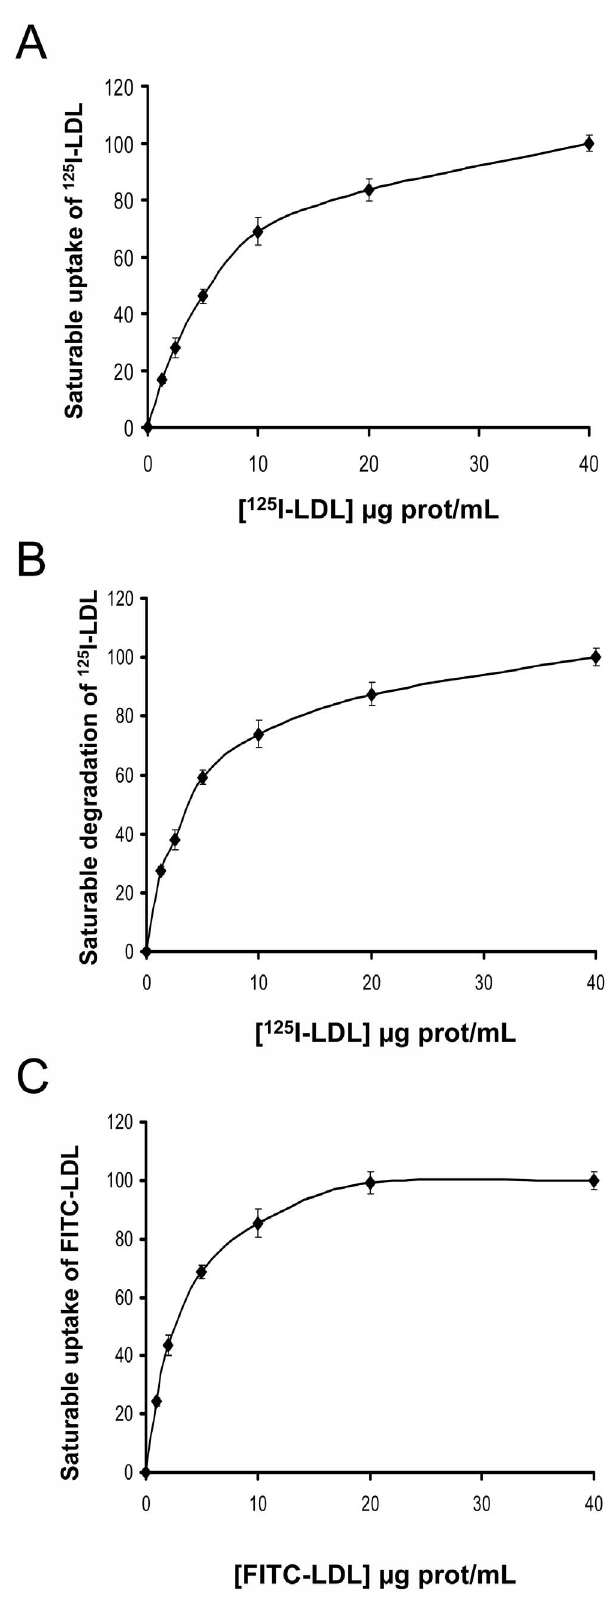
Figure 2. Saturable uptake and degradation of labeled-LDL in CHO- ldlA7 transfected cells with wt LDLR. (A) saturable uptake of 125 I-LDL, (B) saturable degradation of 125 I-LDL and, (C) saturable